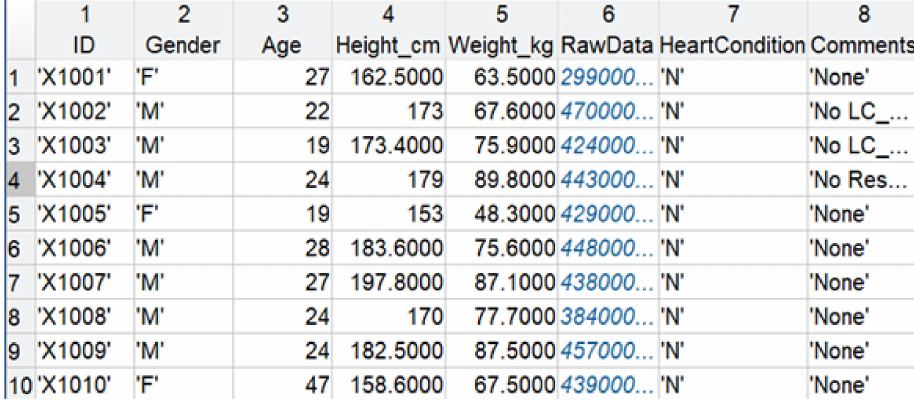
Figure 5. Bed system database excerpt for ten participants.